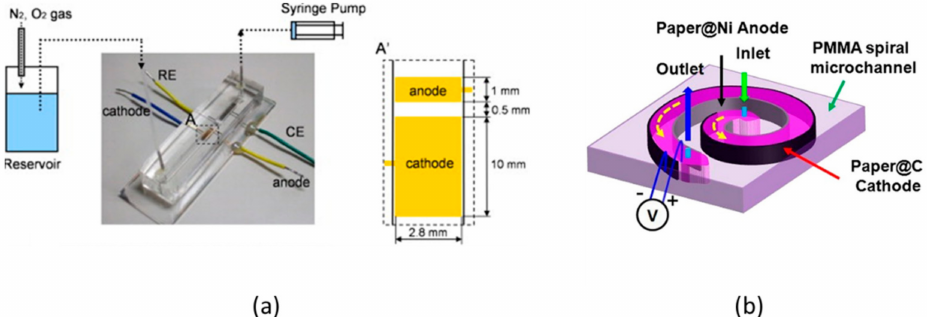
Figure 7. SSMMFCs: ( a ) SSMMFC with anode and cathode in single channel separated by a gap (reprinted from ref. [135]. Copyright 2008 Elsevier) and ( b ) a spiral-shaped SSMMFC (reprinted from ref. [136]. Copyright 2019 Wiley Online